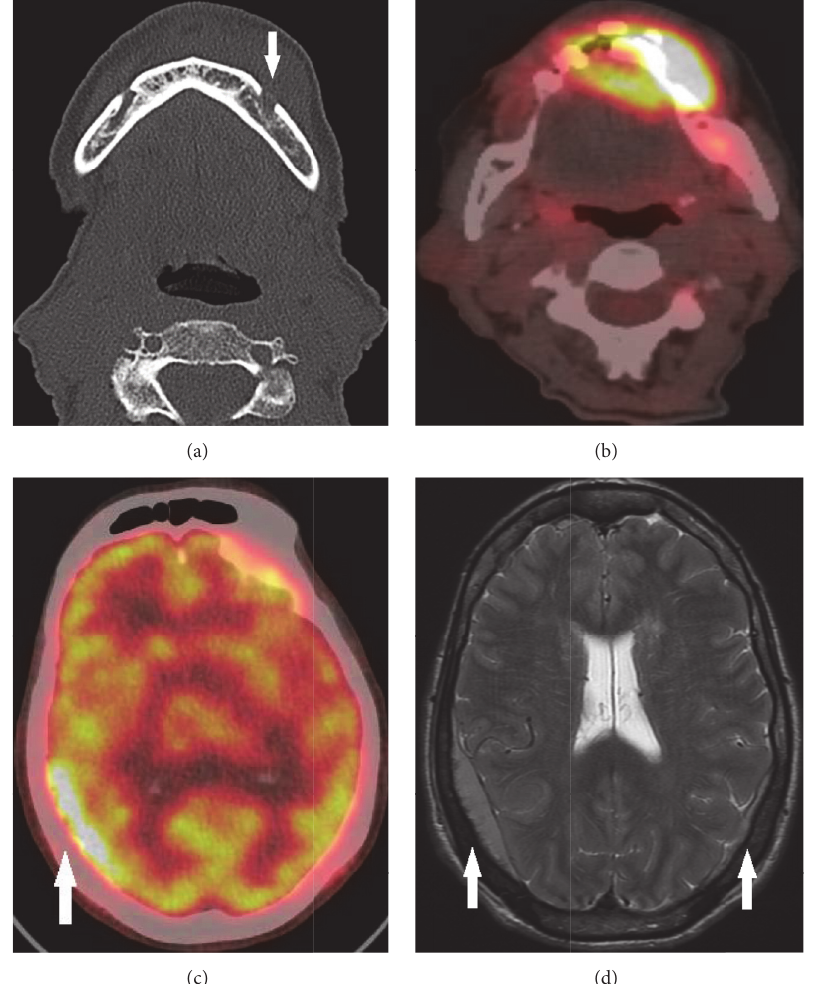
Figure 1: (a) CT of mandible, axial view, showing asymmetrical left alveolar canal widening (arrow); (b) PET CT showing uptake in the left mandible, left buccal mucosa, and left alveolar canal; (c) PET CT, axial view, showing increased uptake overlying the cortex of the right parietal lobe (arrow); (d) T2 weighted axial MRI of brain, showing presence of bilateral dural masses